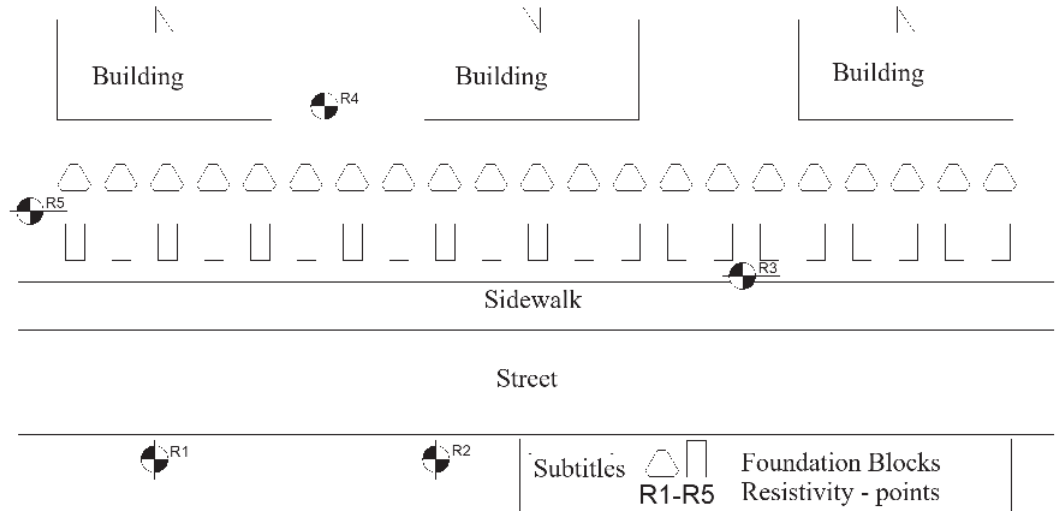
Scheme of the location of old foundations and points of determination of soil resistivity